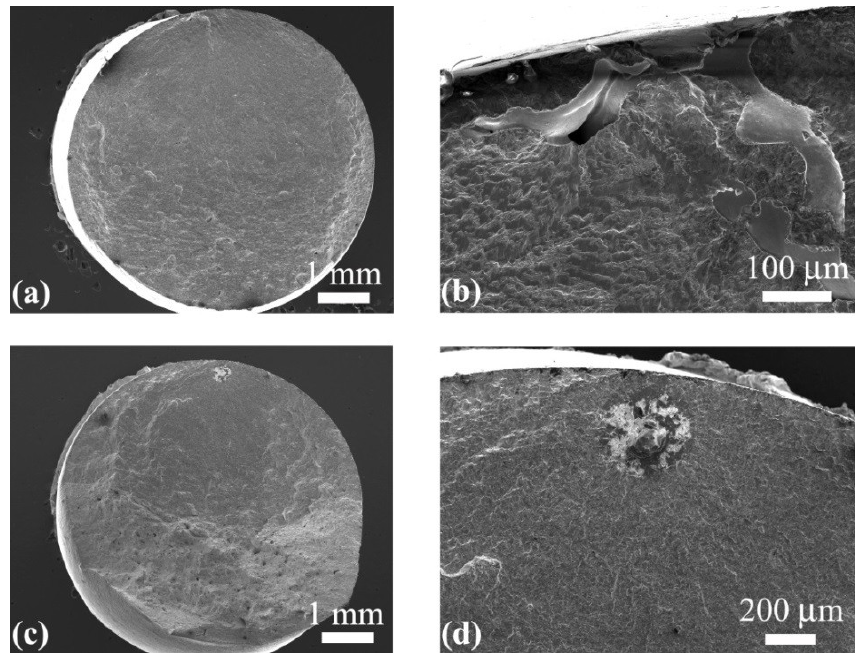
Figure 6. SEM images of the fracture surface for dogbone specimens with single-site crack initiation. ( a , b ): σ a = 220 MPa, N = 2.41 × 10 6 ; ( c , d ): σ a = 350 MPa, N = 2.7 × 10 3